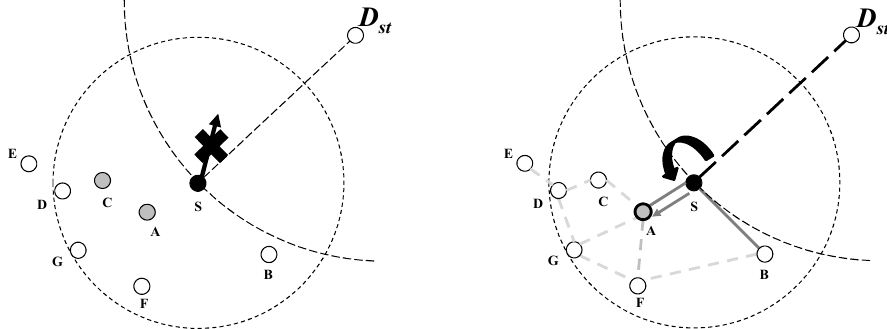
Figure 2. Greedy forwarding failure ( left ) and face routing ( right